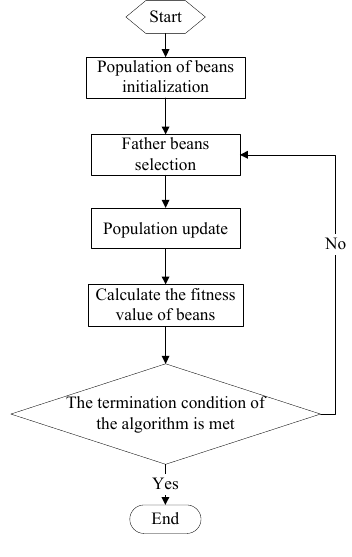
Fig.2 the Flow Chart of